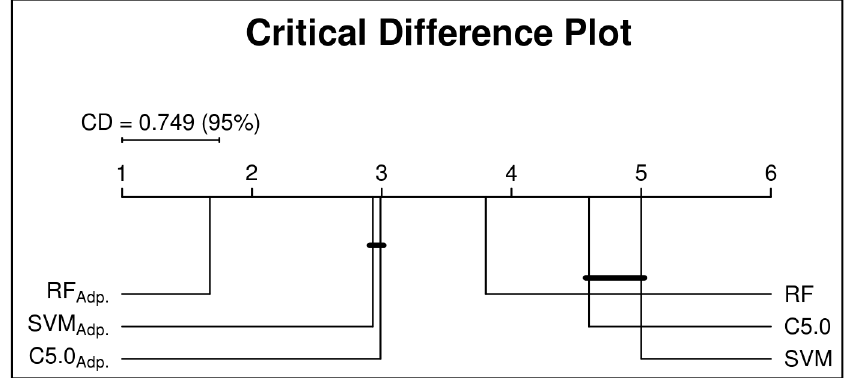
Figure 7. Critical differences plot of the pairwise Nemenyi comparison test for the cut-off (threshold) adaptation experiment.